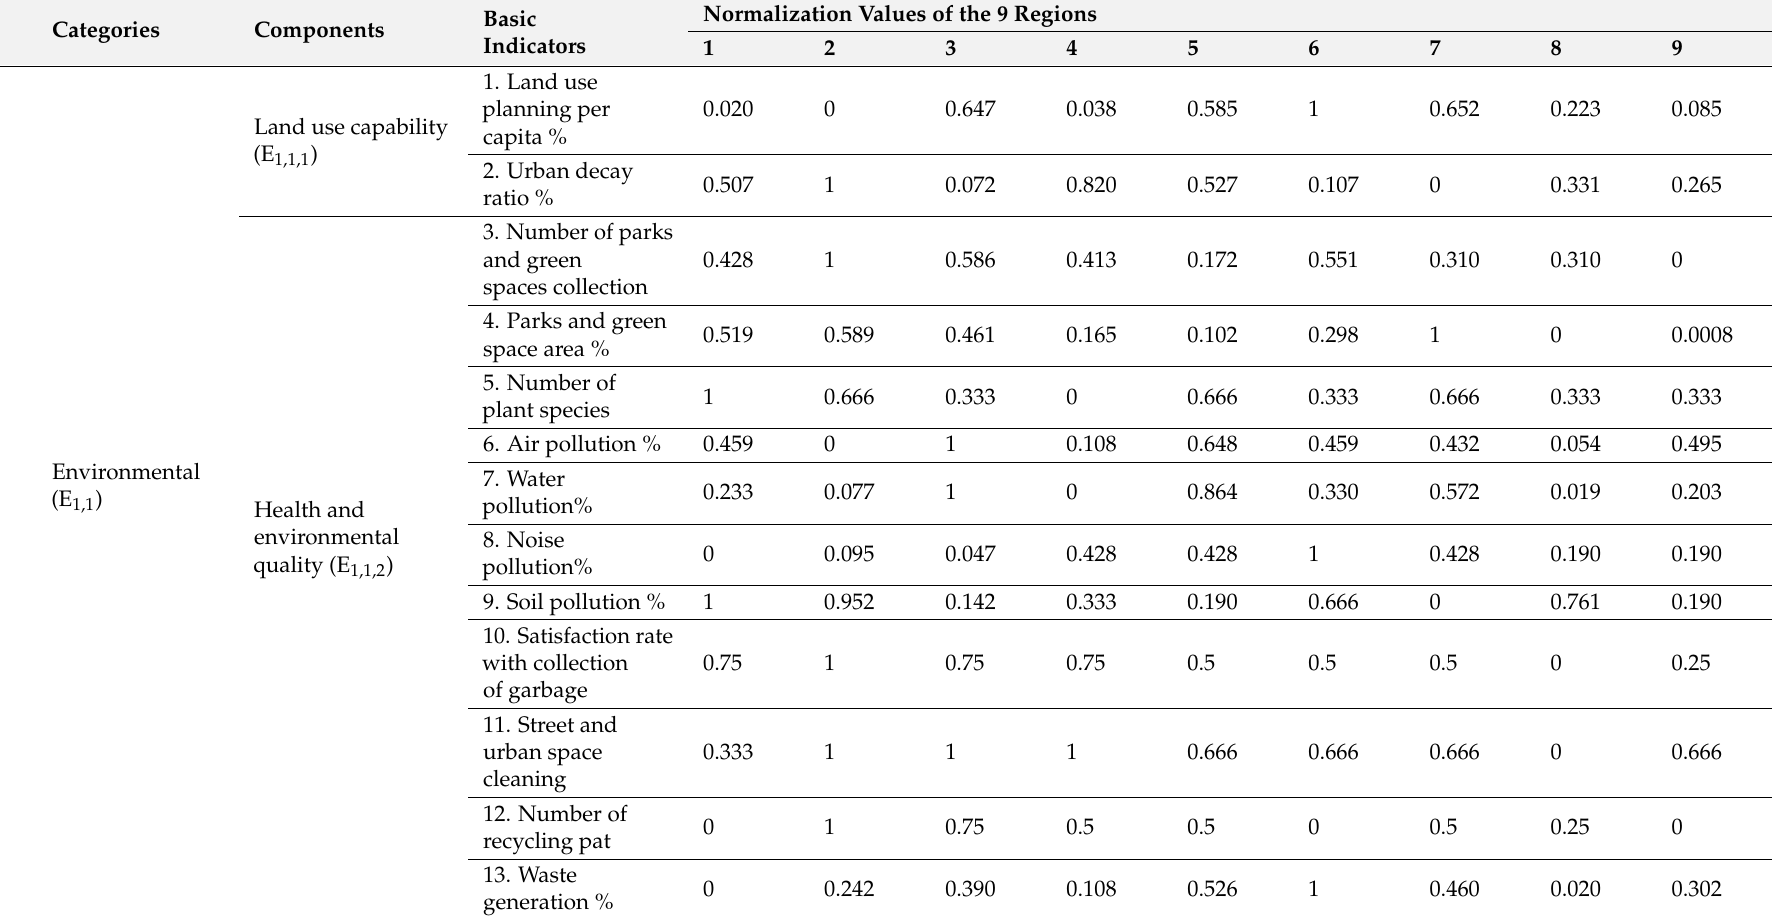
Table 2. Final indicators used to assess the urban sustainability in 9 regions of District 4: Ecosystem well-being/environment (1–18) human well-being/socioeconomic and cultural dimensions